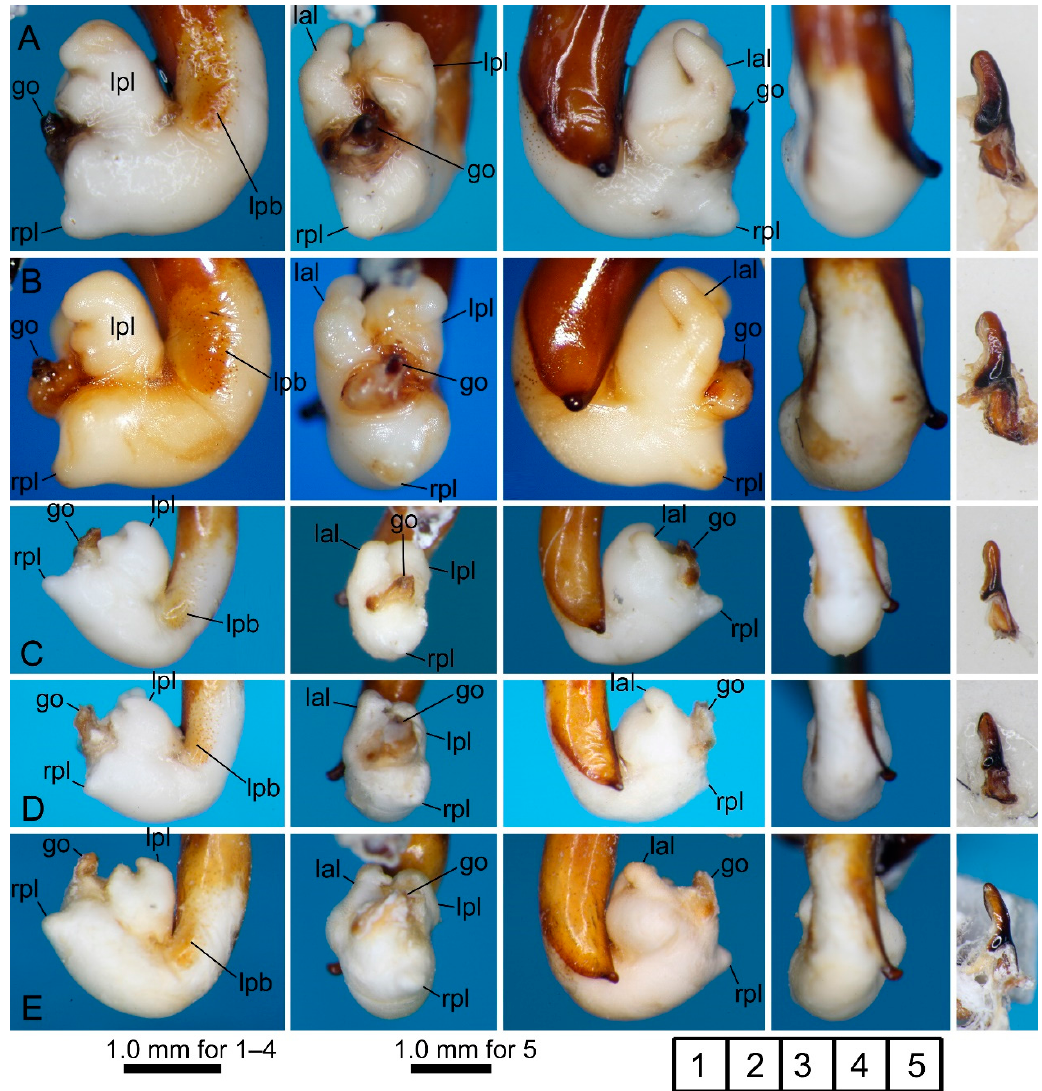
Figure 6. Left lateral ( 1 ), ventral ( 2 ), right lateral ( 3 ), and dorsal ( 4 ) views of aedeagus (part) with the everted endophallus and left lateral view ( 5 ) of right paramere of the macrogenys species group; ( A ), ( B ) P. gassanus male from Goshiki forest road ( A ) and holotype male from “Riv. Tachiyazawagawa” ( B ), ( C – E ) P. iwakiensis males from Miyahisa ( C ) and Nukumidaira ( D ) and holotype male from “Iritôno” ( E